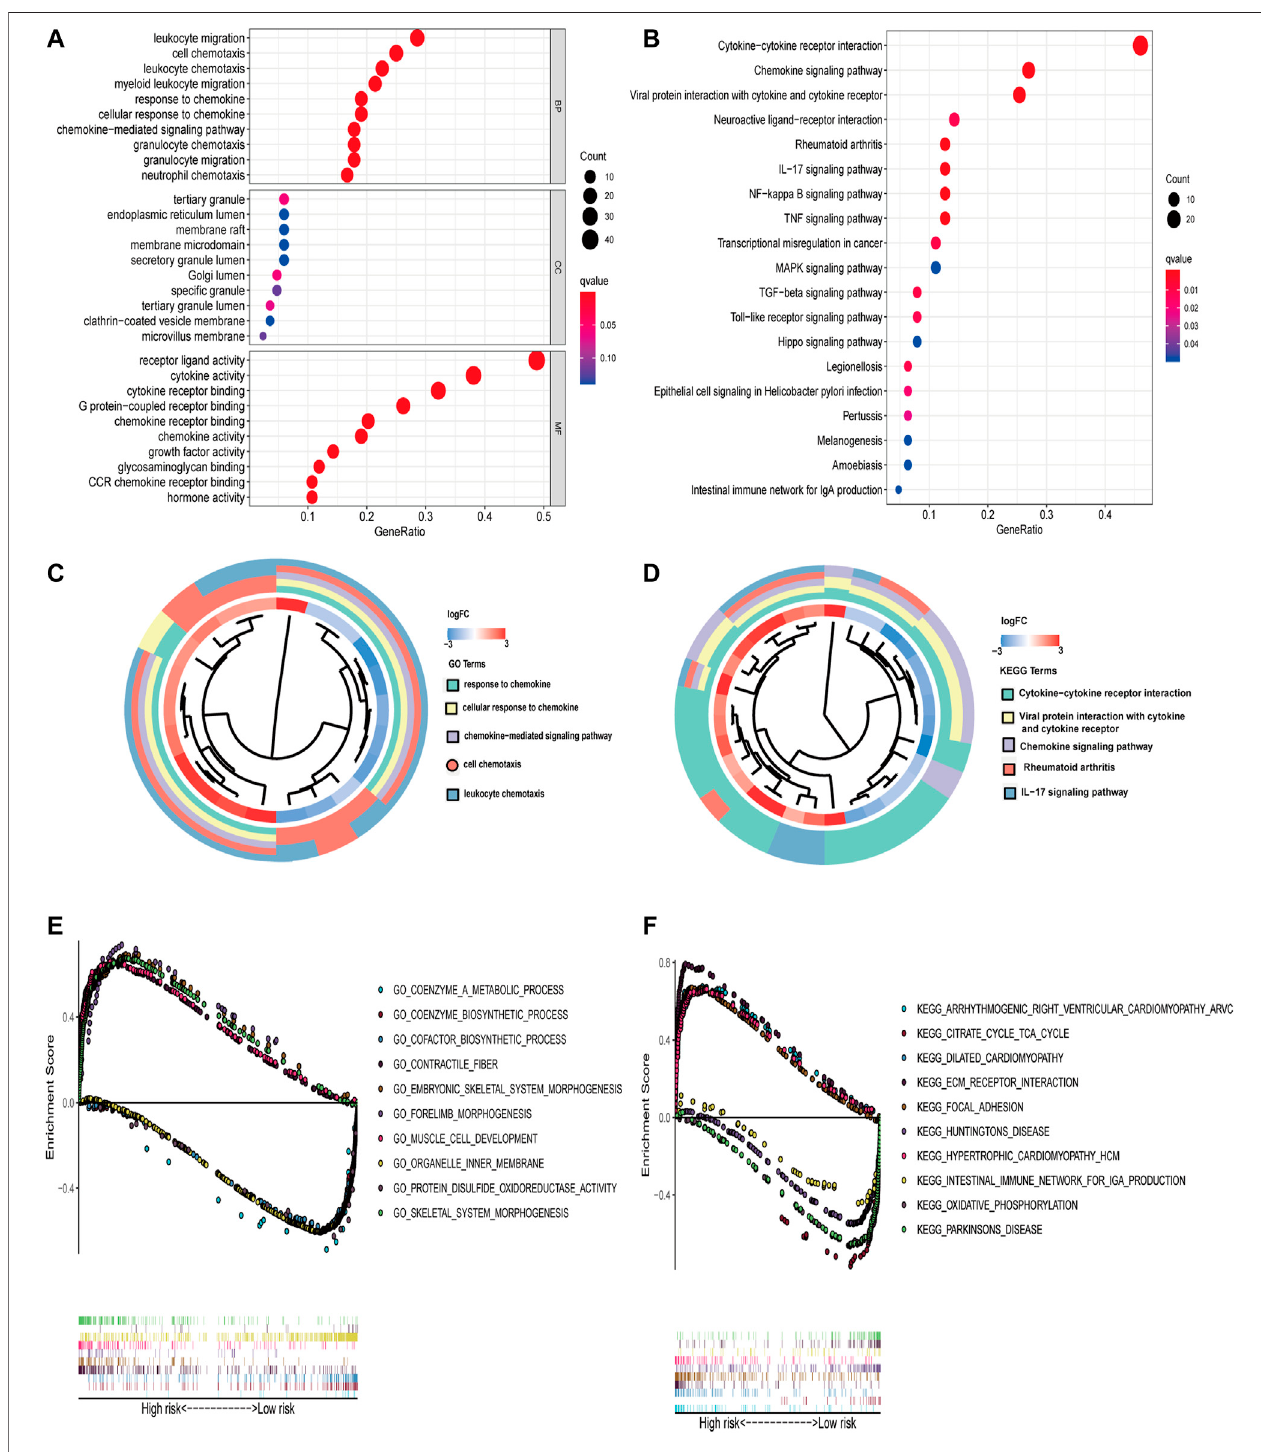
FIGURE5| EnrichmentanalysisofGOandKEGG. (A – C) GOand (B – D) KEGGenrichmentanalysisfor84overlappingDEGs;termswith p < 0.05werebelievedto be enriched signi fi cantly. Several key pathways are visualized using multiple GSEA. (E – F) The plot of GO and KEGG enrichment analysis.